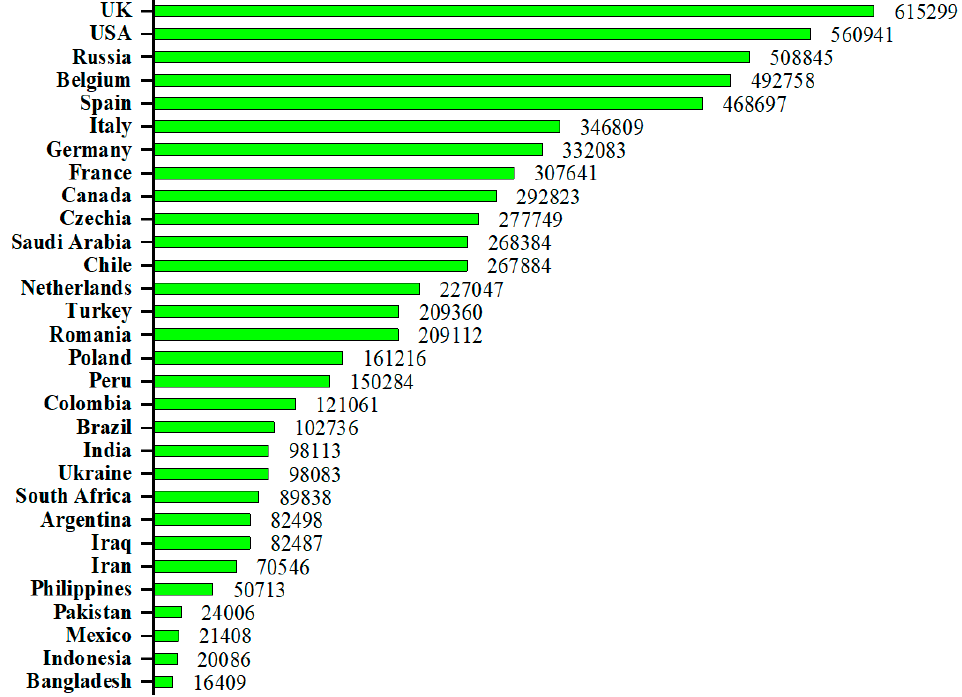
Figure 1. Rate of coronavirus testing performed (per million) in the most impacted countries as of 26 November 2020